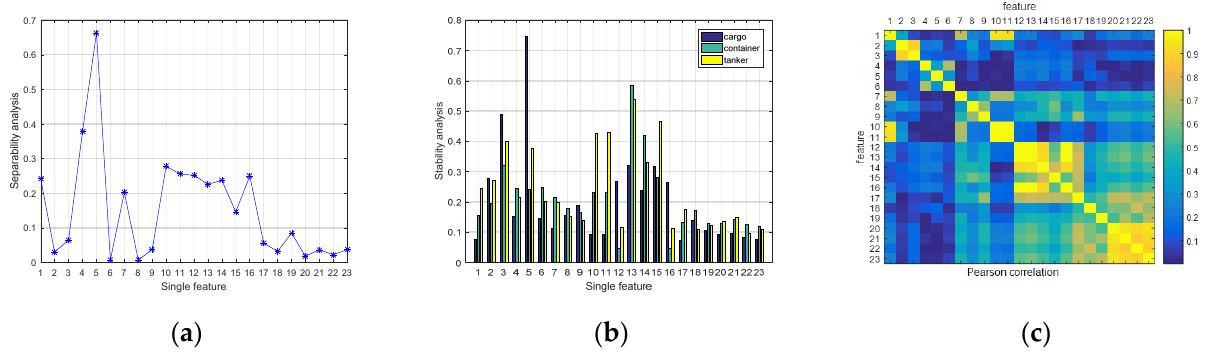
Figure 4. Feature analysis result. ( a ) separability analysis; ( b ) stability analysis; ( c ) Pearson correlation analysis.